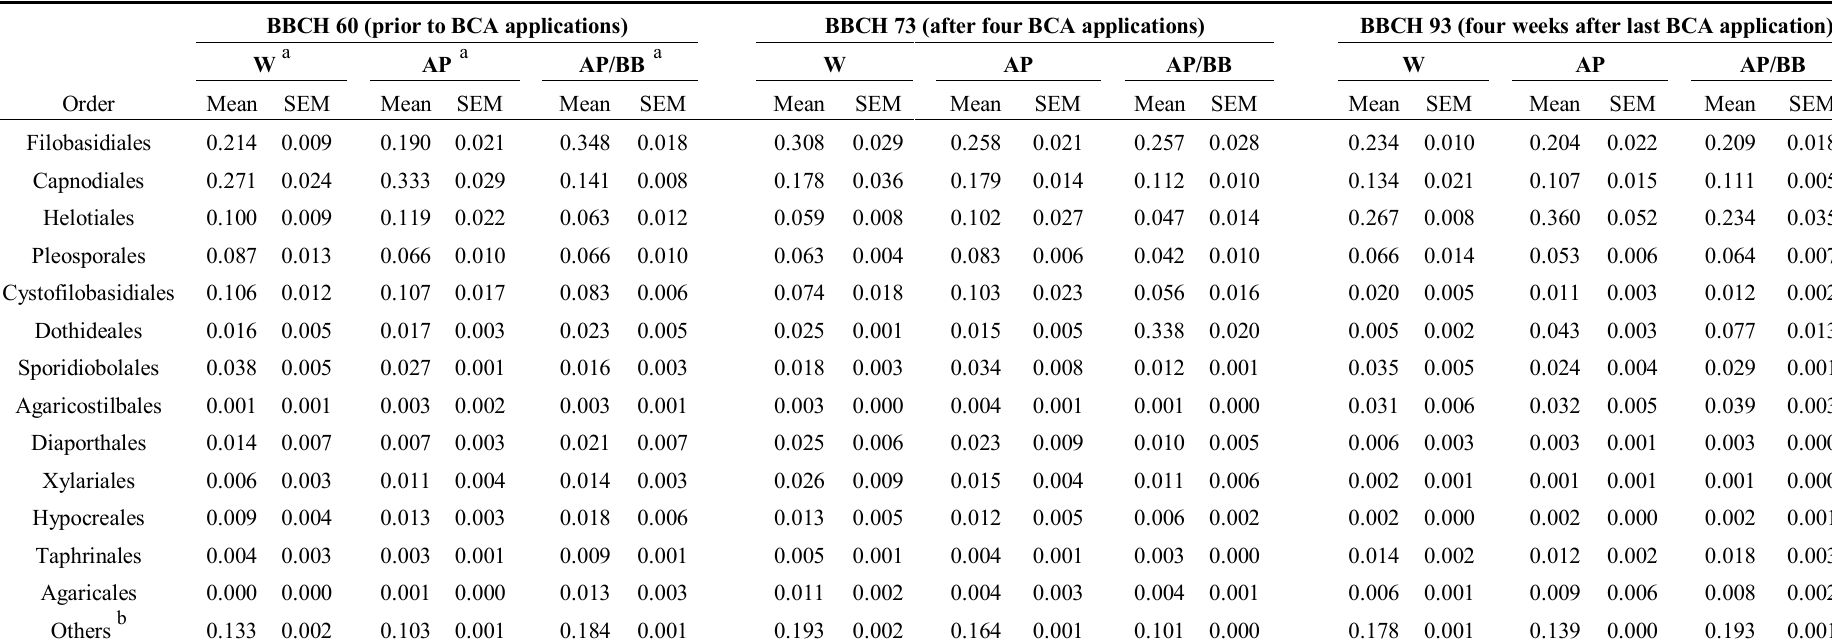
Table 3. Relative abundance of ITS rRNA reads assigned to fungal orders in the strawberry phyllosphere at three distinct phenological stages (BBCH 60, BBCH 73, and BBCH 93) in 2012 as influenced by treatments with Aureobasidium pullulans as a single strain treatment (AP) or co-inoculated with Beauveria bassiana (AP/BB) through commercial formulations. The control (W) was treated with water from a lotic